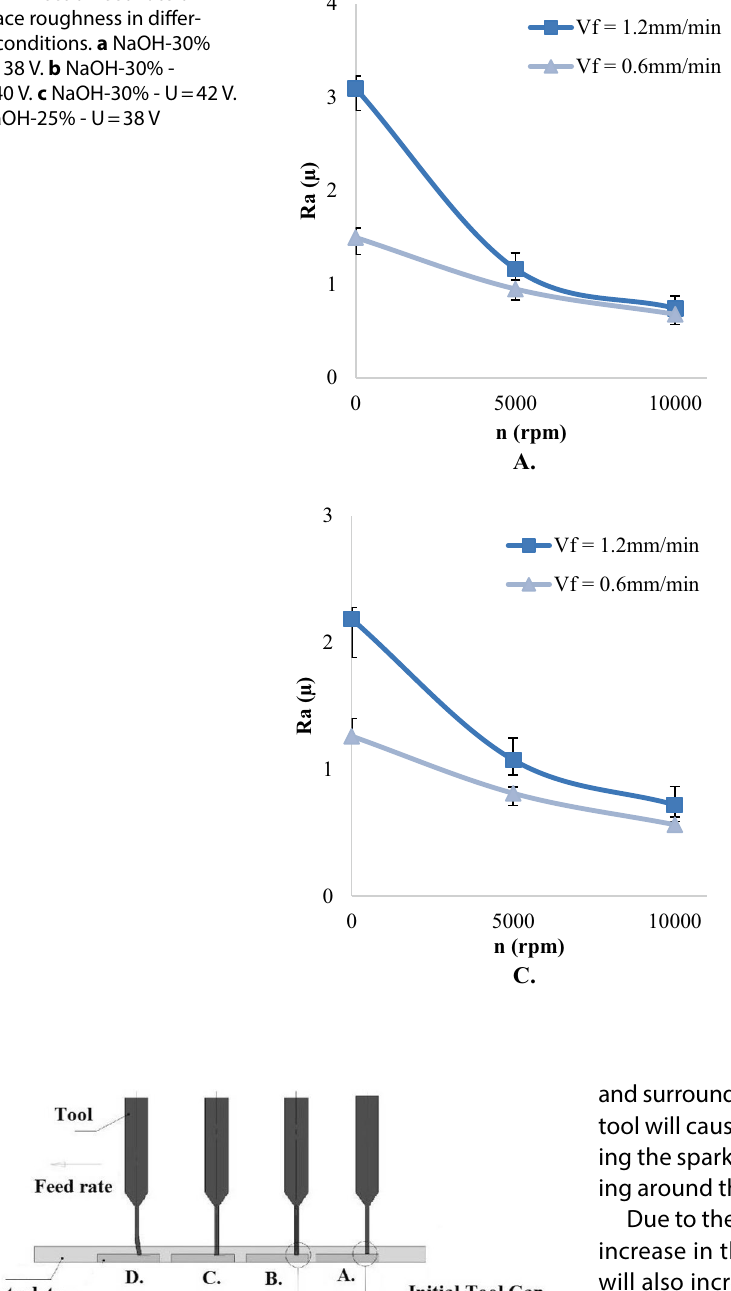
Fig. 9 Effect of feed rate on surface roughness in differ- ent conditions. a NaOH-30% - U = 38 V. b NaOH-30% -